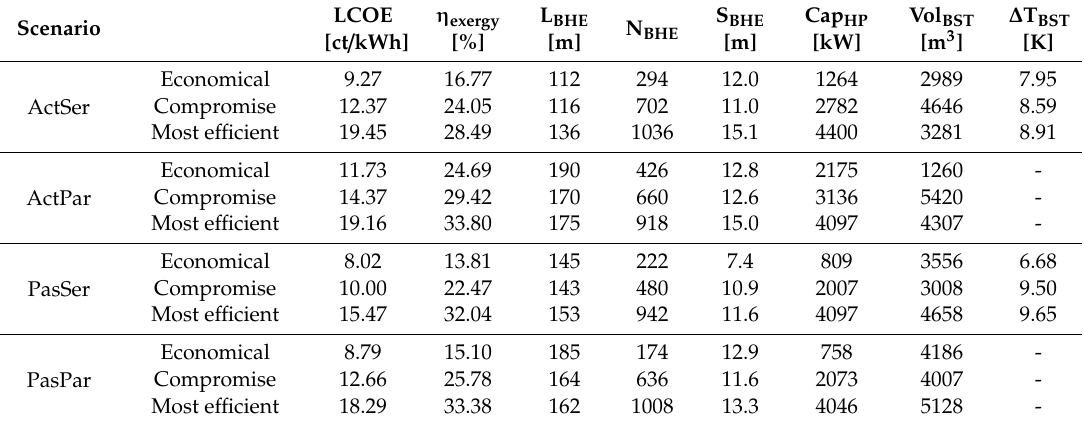
Table 7. The economic, the compromise and the efficient system designs of each scenario.